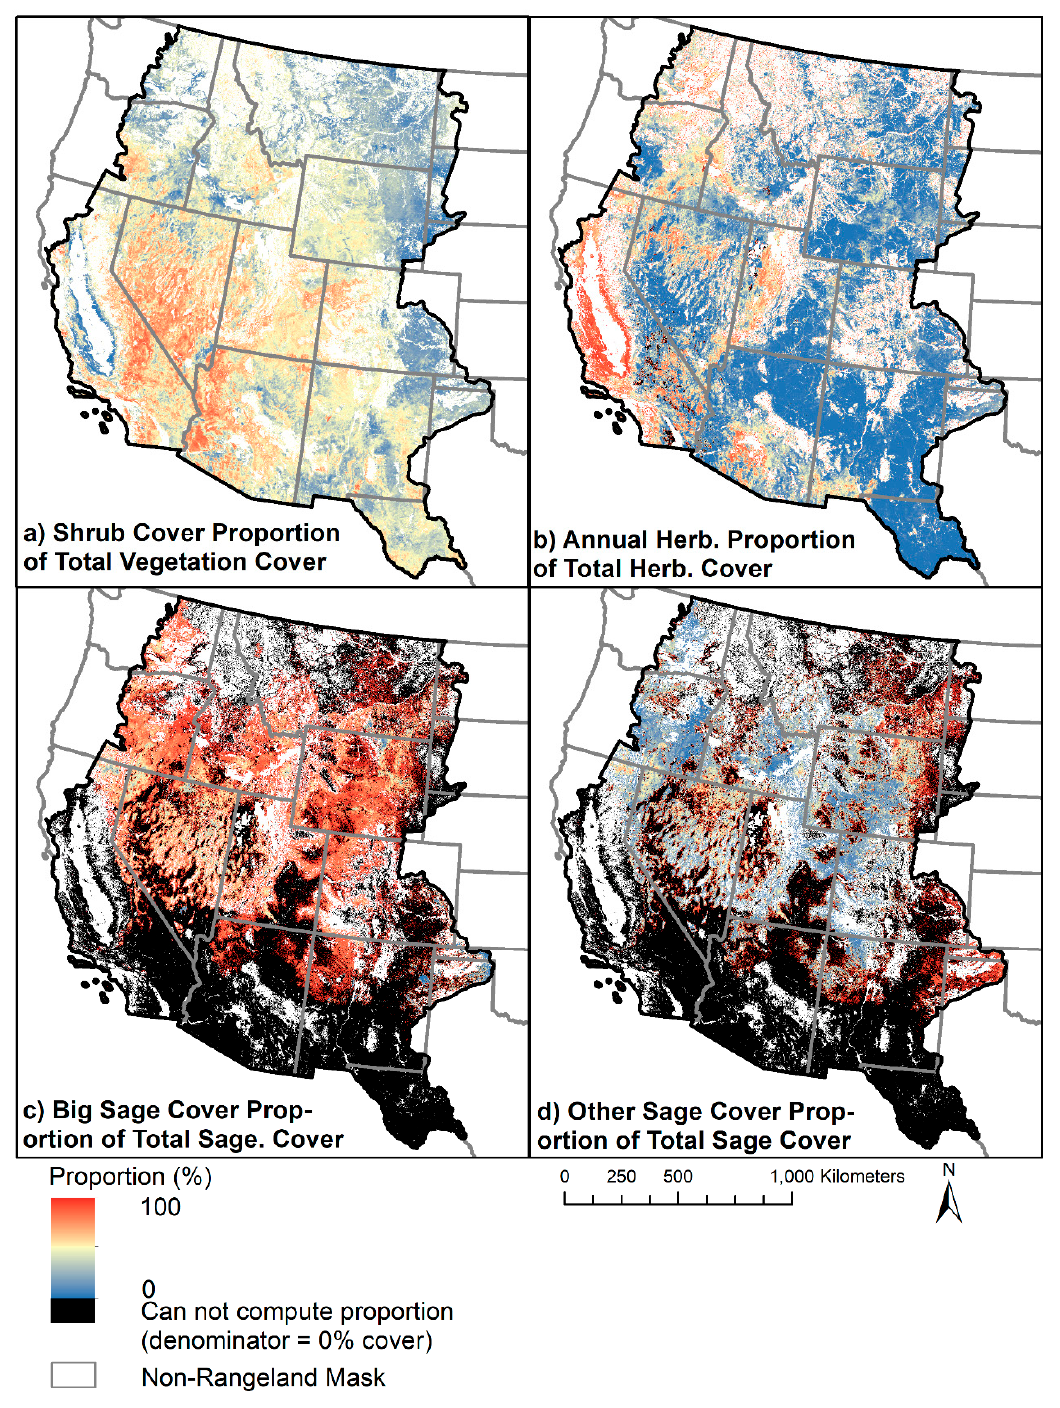
Figure 7. Fractional cover proportions. ( a ) shrub cover proportion of total vegetation (shrub + herbaceous) cover, ( b ) annual herbaceous proportion of herbaceous cover, ( c ) big sagebrush proportion of sagebrush cover, and ( d ) other sagebrush (sagebrush – big sagebrush) proportion of sagebrush cover. Sagebrush cover over the study area averages 4.3%, big sagebrush 2.9%, and other sagebrush 1.4%. In terms of spatial extent, sagebrush, big sagebrush, and other sagebrush occurs on 41.5%, 35.7%, and 28.8% of the study area, respectively. Within their respective ranges, average sagebrush, big sagebrush, and other sagebrush cover is 10.3%, 8.4%, and 4.4%, respectively. Of pixels with sagebrush present, big sagebrush and other sagebrush co-exist on 55.9% of pixels. Big sagebrush is the predominate